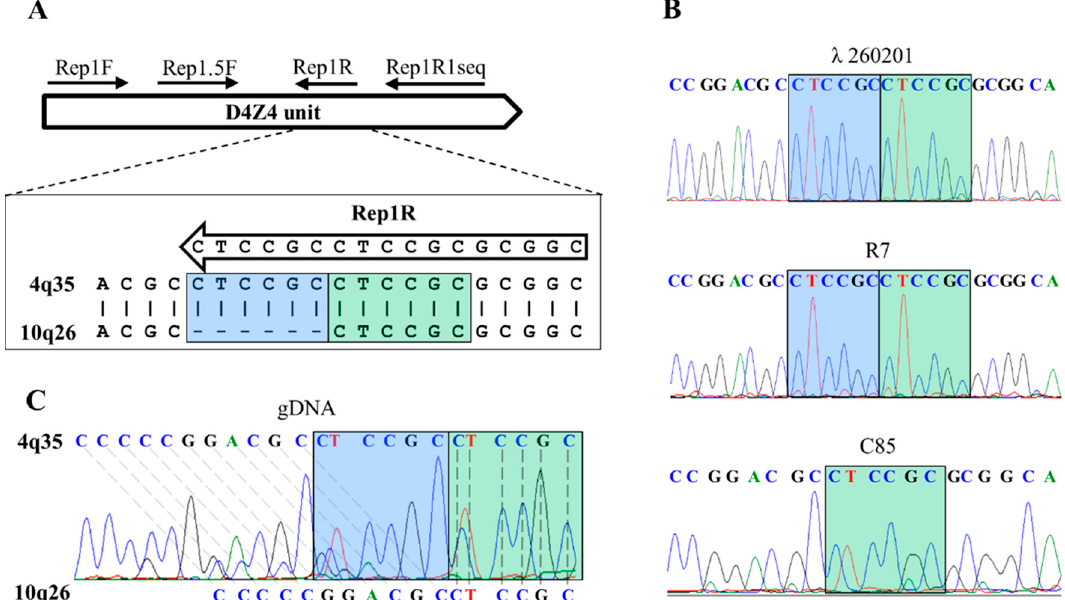
Figure 1. Differences in D4Z4 sequences of chromosomes 4q35 and 10q26. ( A ) Schematic representation of primers’ positions within D4Z4 unit. The position of each primer indicated by a black arrow and signed on top. The alignment of regions of the six-nucleotide differences is presented below the primers scheme. Two CTCCGC repeats are unique for chromosome 4q35 and are highlighted by two colored rectangles. The 4q35-specific primer Rep1R sequence is placed inside a black arrow. In the case of PCR for sequencing, the primers pair Rep1F + Rep1R1seq was used; in the case of qPCR for 4q35 D4Z4 arrays sizing, the primers pair Rep1.5F + Rep1R was used. ( B ) Sequence of PCR products obtained by using Rep1F + Re1R1seq primers pair and control matrices: λ 260201 (4q35 specific cosmid); R7 (PFGE gel fragment with 4q35 D4Z4 array of DNA sample with known sizes of D4Z4 arrays); C85 (10q26 specific cosmid). In colored rectangles CTCCGC repeats are highlighted. ( C ) Sequence of PCR products obtained by Rep1F + Re1R1seq primers pair and native gDNA matrix. The sequence contains two types of the D4Z4 repeats: 4q35-specific (top row) and 10q26-specific (bottom